Question: According to the figure, is the described quantity increasing or decreasing?
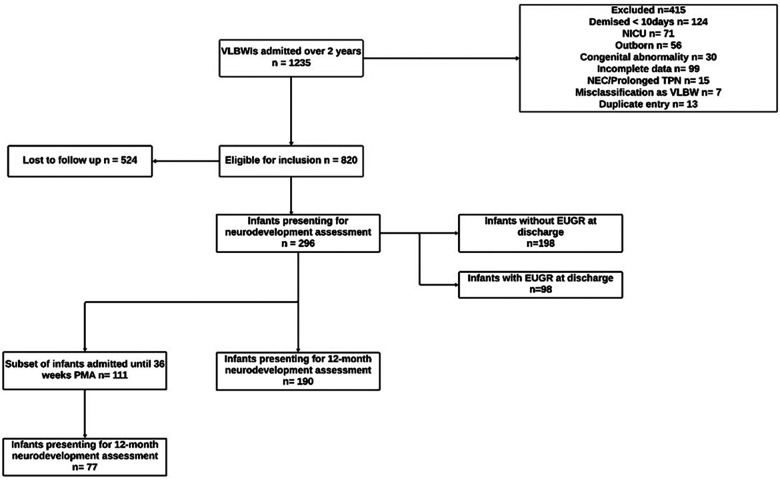
Answer: increasing